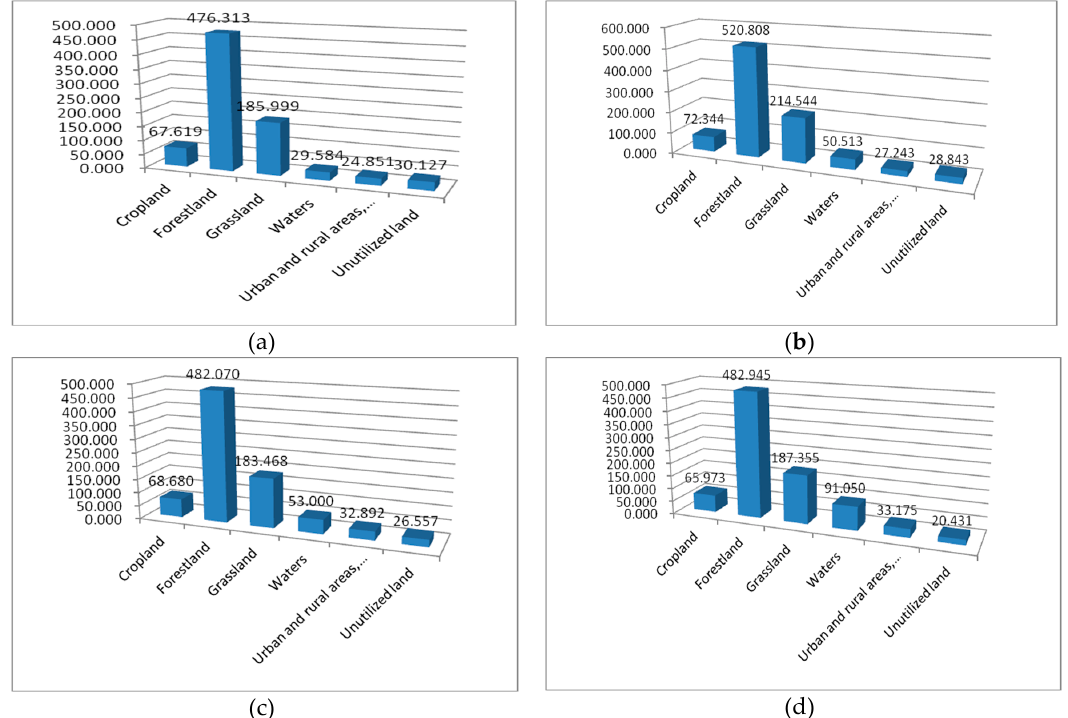
Figure 6. The mean of patch area (AREA-MN) changes of various type of landscapes. (a) The AREA-MN in 2000; (b) the AREA-MN in 2008; (c) the AREA-MN in 2013; (d) the AREA-MN in 2017 (unit: ha).